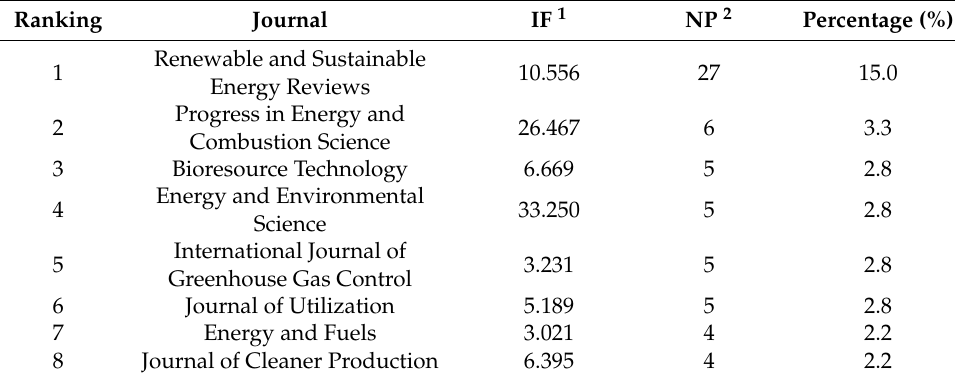
Table 5. Distribution of review papers in scientific journals in the field of CCU.